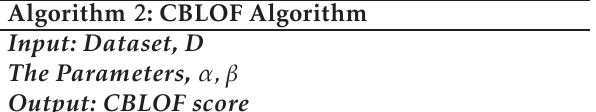
Algorithm 2: CBLOF